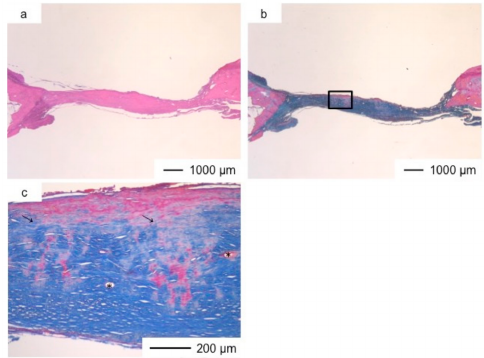
Figure 5. Light microscopic images of ChGCa in cranioplasty two years after implantation, stained by HE ( a ) and Light microscopic images of ChGCa in cranioplasty two years after implantation, stained by AM ( b ); ( c ) Magnification of the inset in ( b